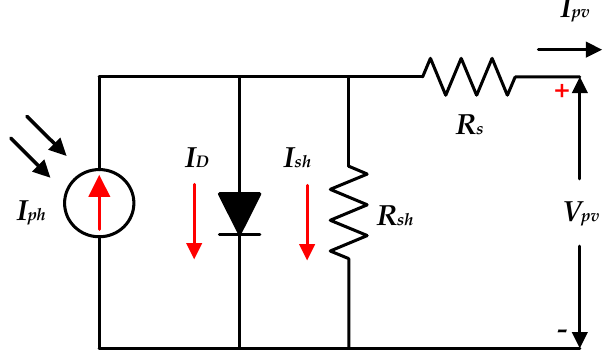
Figure 1. Electrical equivalent diagram for single diode PV model.